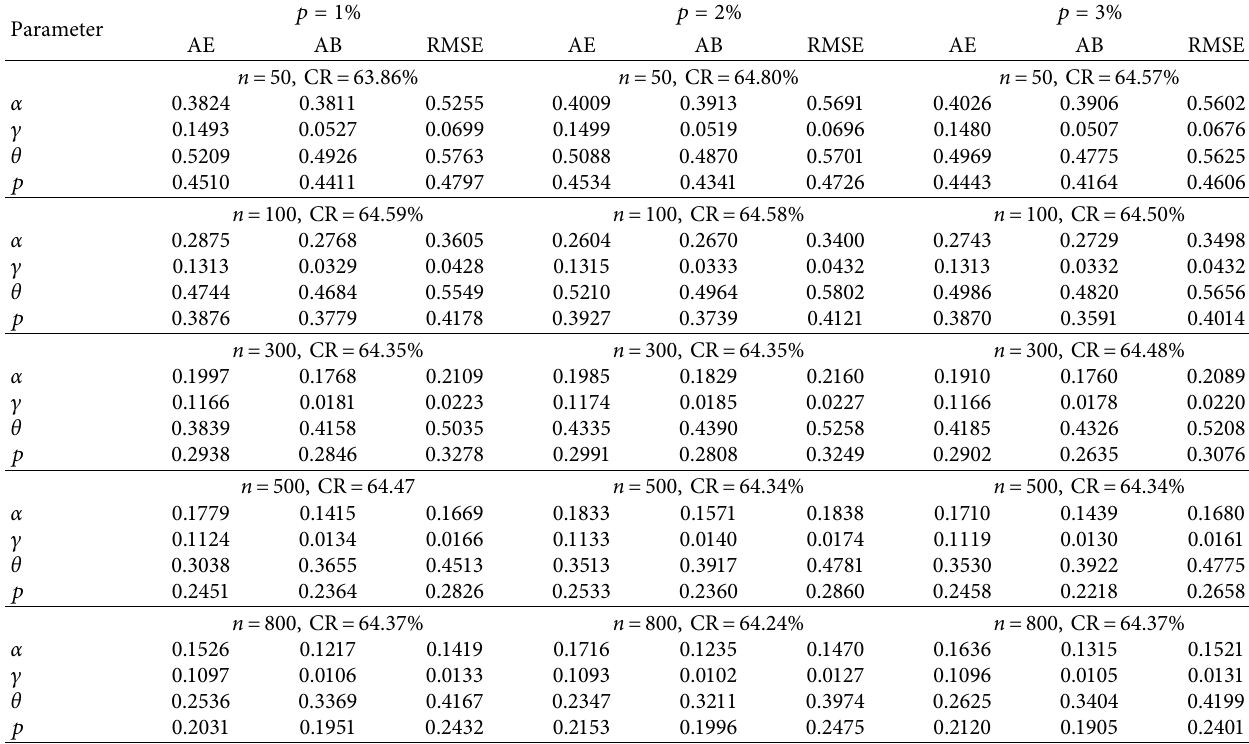
Table 3: Simulation results of SWGI distribution for parameter values ( α , c , θ ) � ( 0 . 2 , 0 . 1 , 0 . 2 ) .